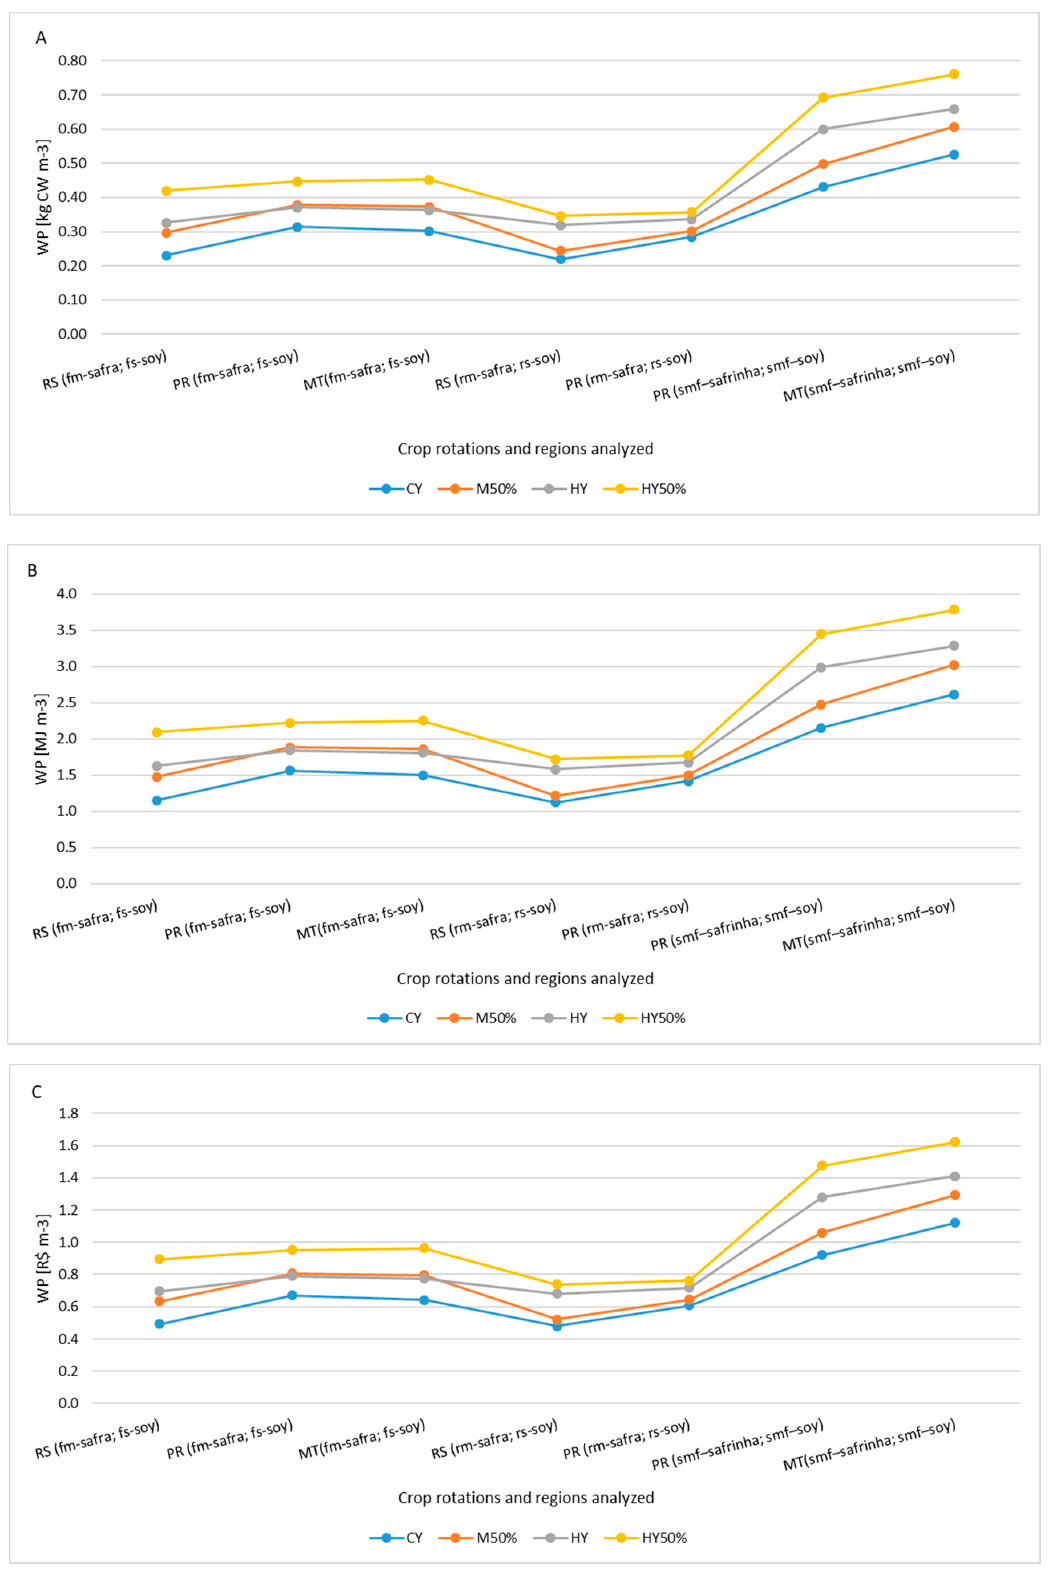
Figure 4. Water productivity of broiler chicken production considering the crop rotation systems and the 2nd scenario (M50%), 3rd scenario (HY), and 4th scenario (HY50%). ( A ) Carcass Weight reference unit (WP indirect+direct,poultry,Mass,Farm ). ( B ) Food Energy reference unit (WP indirect+direct,poultry,Energy,Farm ). ( C ) Monetary reference unit (WP indirect+direct,poultry,Mon,Farm ). s—soy; m—maize; f—fallow; r—ryegrass.